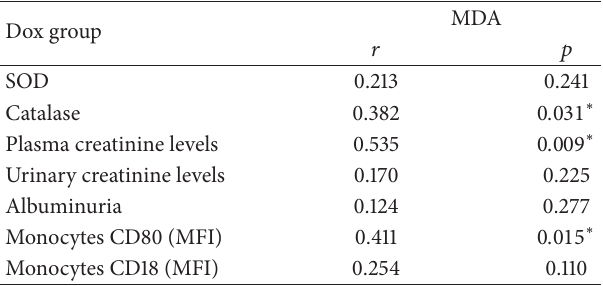
Table 2: Correlations of redox status in kidney tissue, renal function parameters, and immune markers in rats with nephrotic syndrome induced by